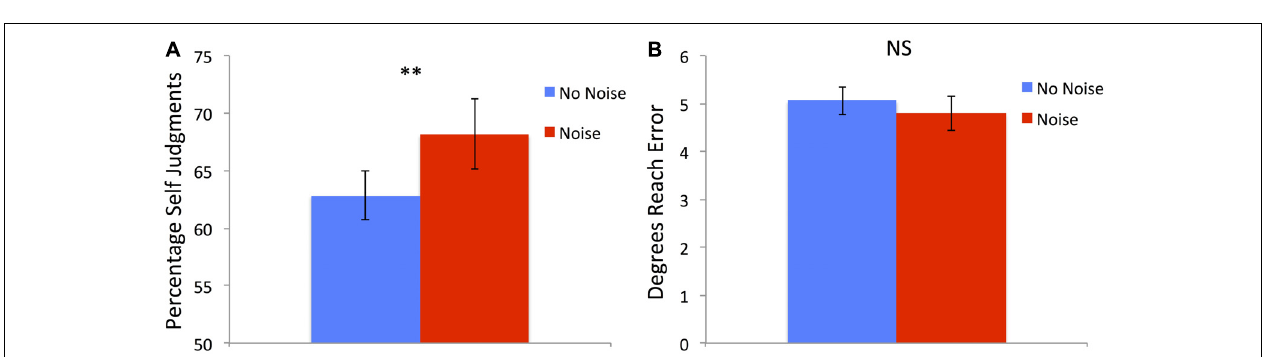
FIGURE 2 | Schematic of a single trial. 500 ms after the vBOT moved the limb to the start location a target appeared for 1000 ms followed by a tone indicating for participants to begin their reach. A white cursor represented the movements of the real limb and was either an exact